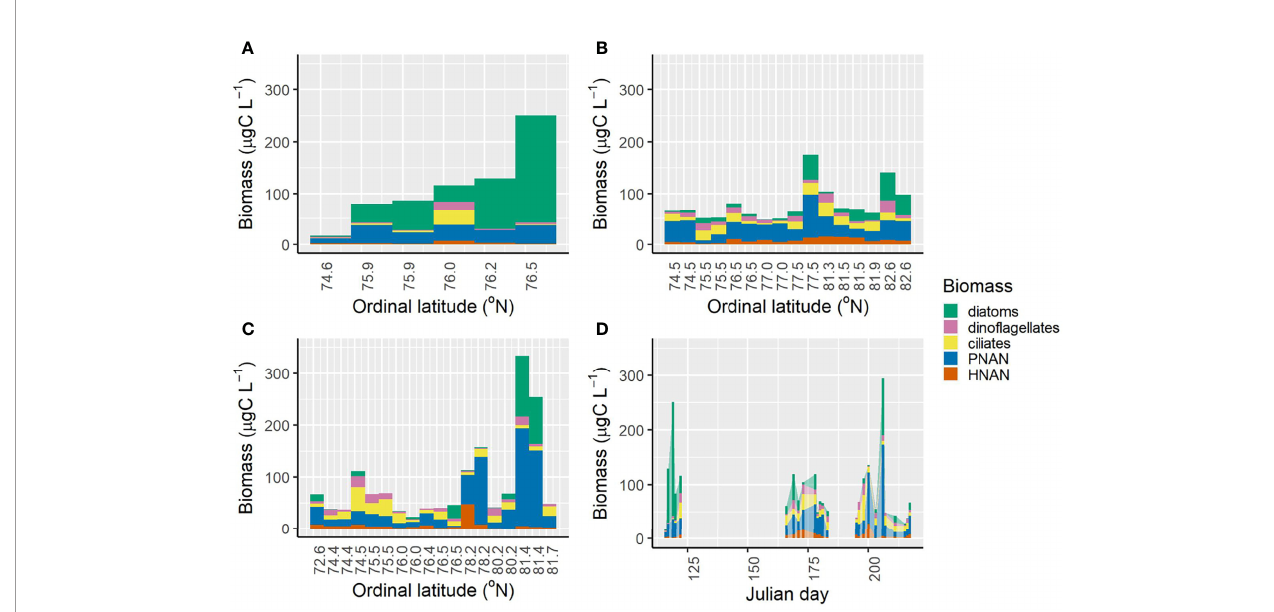
FIGURE 3 | Biomasses derived from cell count data for (A) HH180423 (spring 2018) (B) JR17006 (summer 2018) (C) JR16006 (summer 2017), organised by latitude and (D) all samples, aggregated by Julian day, with linear interpolation between samples separated by fewer than 10 Julian days. PNAN indicates phototrophic nano fl agellates. HNAN indicates heterotrophic nano fl agellates.